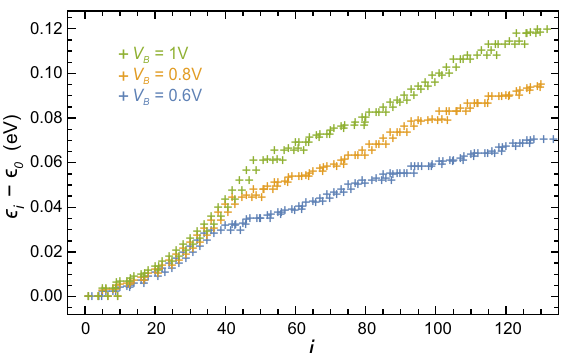
Figure 10. Excitation energies, (cid:101) i − (cid:101) 0 , in the case of model 2 ( R = 40 nm and a = 200 nm) vs. the solution order, i , for three bias voltages. Lower curve: V B = 0.6 V; middle curve: V B = 0.8 V; upper curve: V B = 1